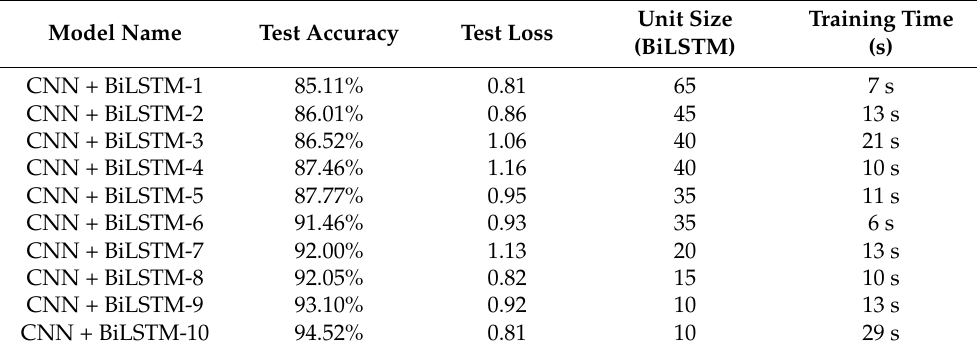
Table 5. The tested CNN + BiLSTM models’ test accuracy, test loss, and training